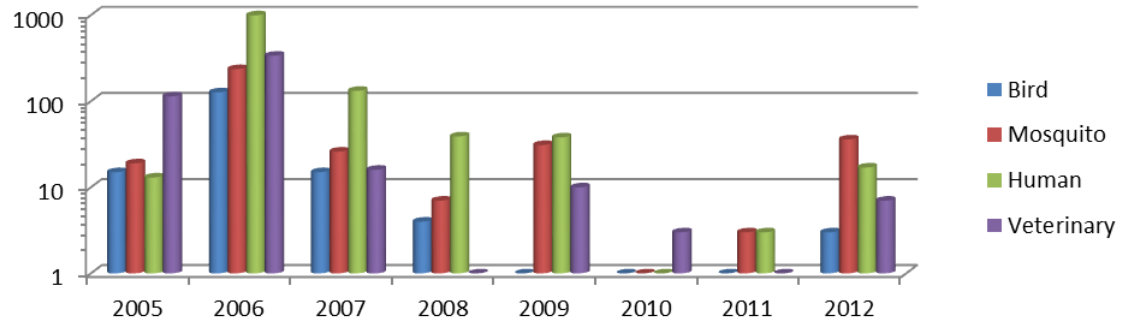
Figure 1. WNV infections detected in Idaho, 2005–2012. Y axis represents the number of infections in logarithmic scale and the X-axis represents